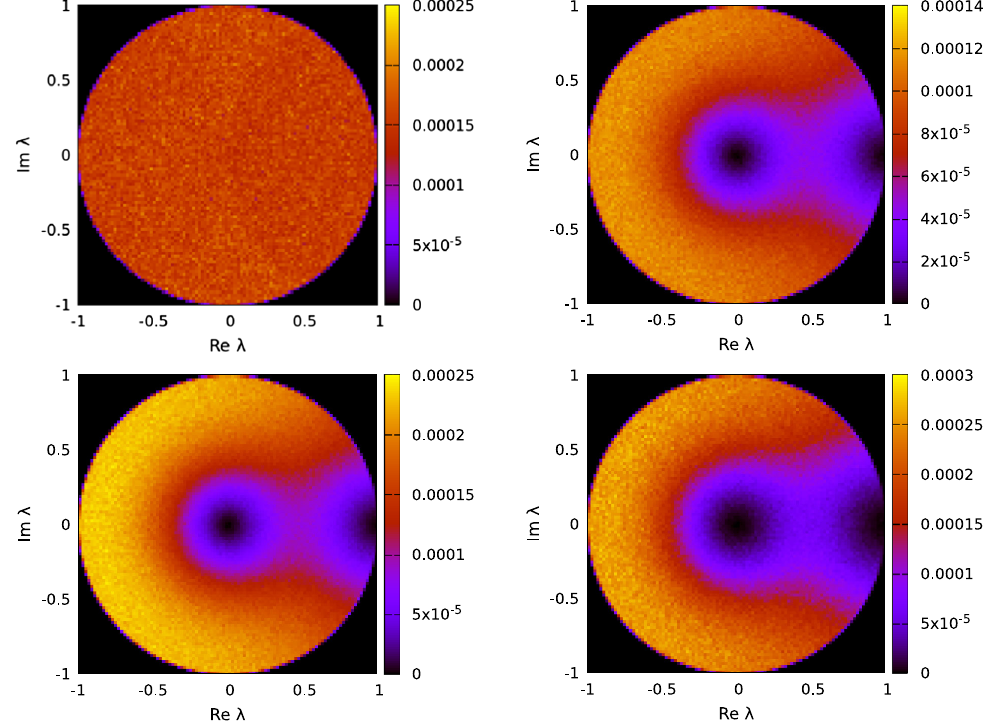
FIG. 6. Distribution of complex spacing ratios, Eq. (17), for N ¼ 24 and q ¼ 2 (top-left panel), 3 (top-right panel), 4 (bottom-left panel), and 6 (bottom-right panel). The results are qualitatively similar to those for N ¼ 20